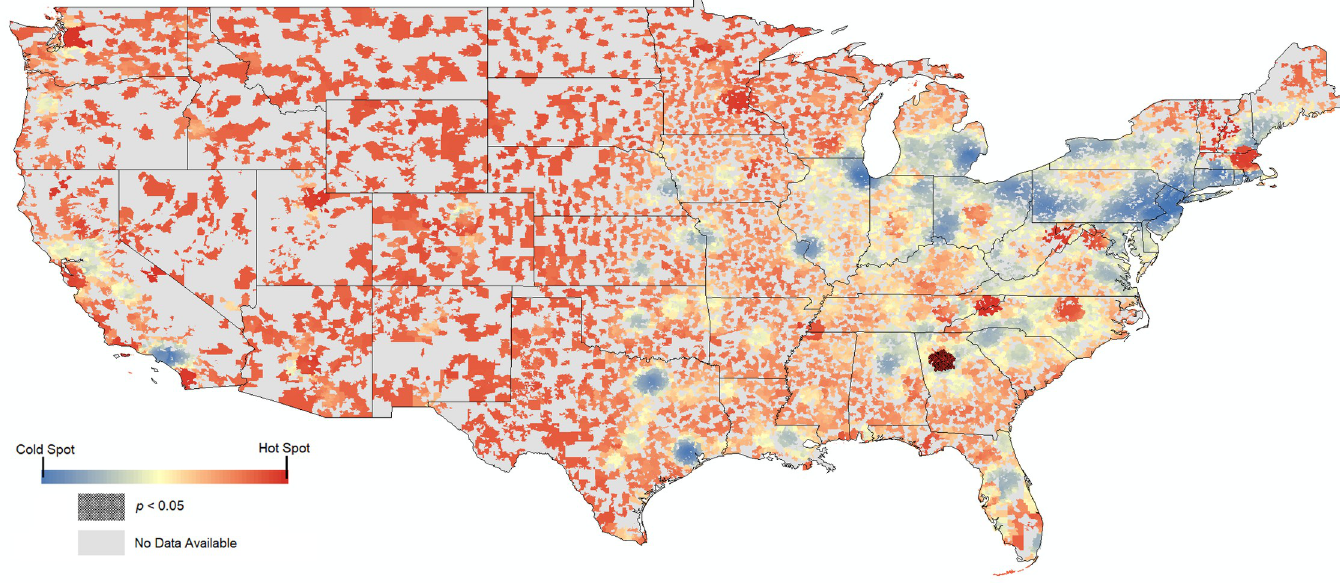
Fig 1. In blue-red gradient, results of a hot spot analysis using zip code averages for payment amount per physician in the contiguous United States. Hatched overlay represents zip codes where hot spot reached statistical significance, and gray zip codes are those with no data. Cartographic boundaries obtained from the U . S . Census Bureau and reprinted with permission in accordance with OMB Memorandum M-10-06 and Executive Order 13642 .